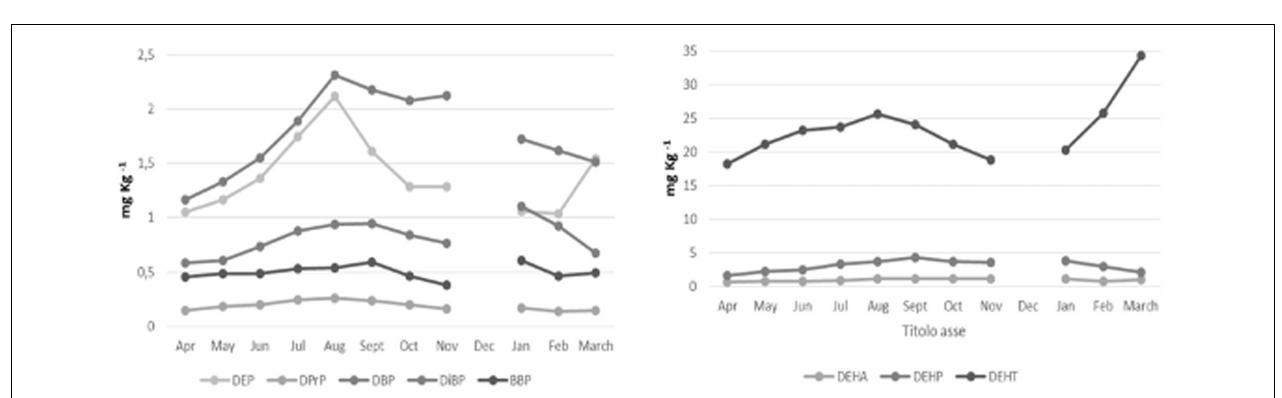
FIGURE 3 | Seasonal variation of single PAE congeners, DEHA and DEHT in Sparus aurata from Mahdia coast (Tunisia) during the period April 2018 to March 2019.